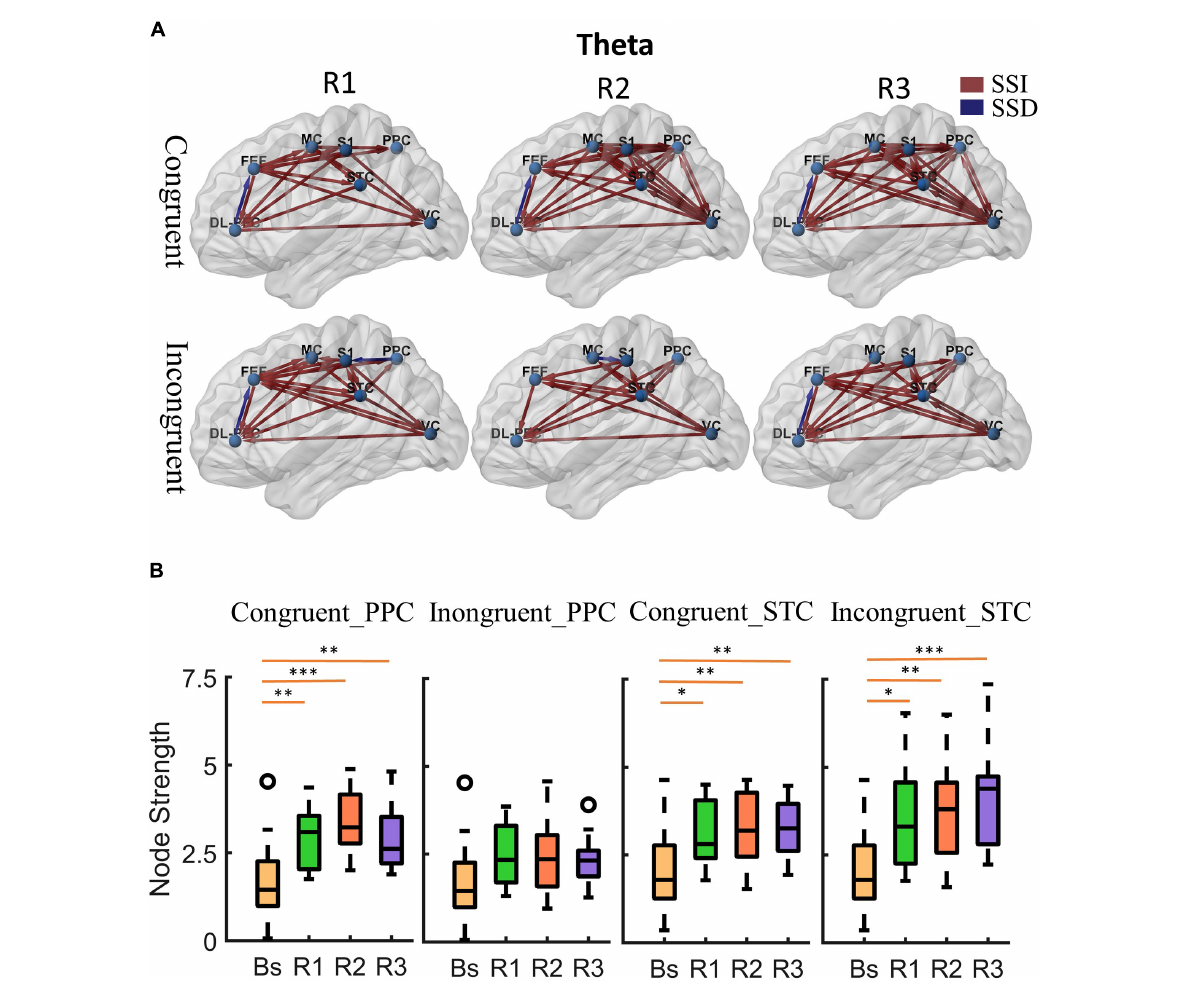
FIGURE4 Cortical activity in theta band. (A) Changes of theta band cortical connectivity compared to standing baseline in congruent and incongruent conditions. Red lines indicate a statistically significant increase (SSI) in connectivity compared to baseline, and blue lines indicate a statistically significant decrease (SSD) in connectivity compared to baseline ( p < 0.05). Significances were calculated using paired t -tests and corrected by the false discovery rate (FDR) method. The cortical areas of interest are as follows: dorsolateral prefrontal cortex (DL-PFC), frontal eye field cortex (FET), motor cortex (MC), primary somatosensory (S1), posterior parietal cortex (PPC), superior temporal cortex (STC), visual cortex (VC). The arrows represent the direction of information flow. (B) Theta band node strength in posterior parietal and superior temporal cortices. Paired t -tests were used to determine the difference in node strength between rotating phase (R1, R2, R3) and baseline and were corrected for multiple comparisons using Bonferroni. Congruent _PPC: Node strength of posterior parietal cortex in the congruent condition. Inongruent_PPC: Node strength of posterior parietal cortex in the incongruent condition. Congruent _STC: Node strength of superior temporal cortex in the congruent condition. Inongruent_STC: Node strength of superior temporal cortex in the incongruent condition. The upper and lower error bars of the bins are the upper and lower quartiles of the data, respectively. ∗ p < 0.05, ∗∗ p < 0.01, ∗∗∗ p <